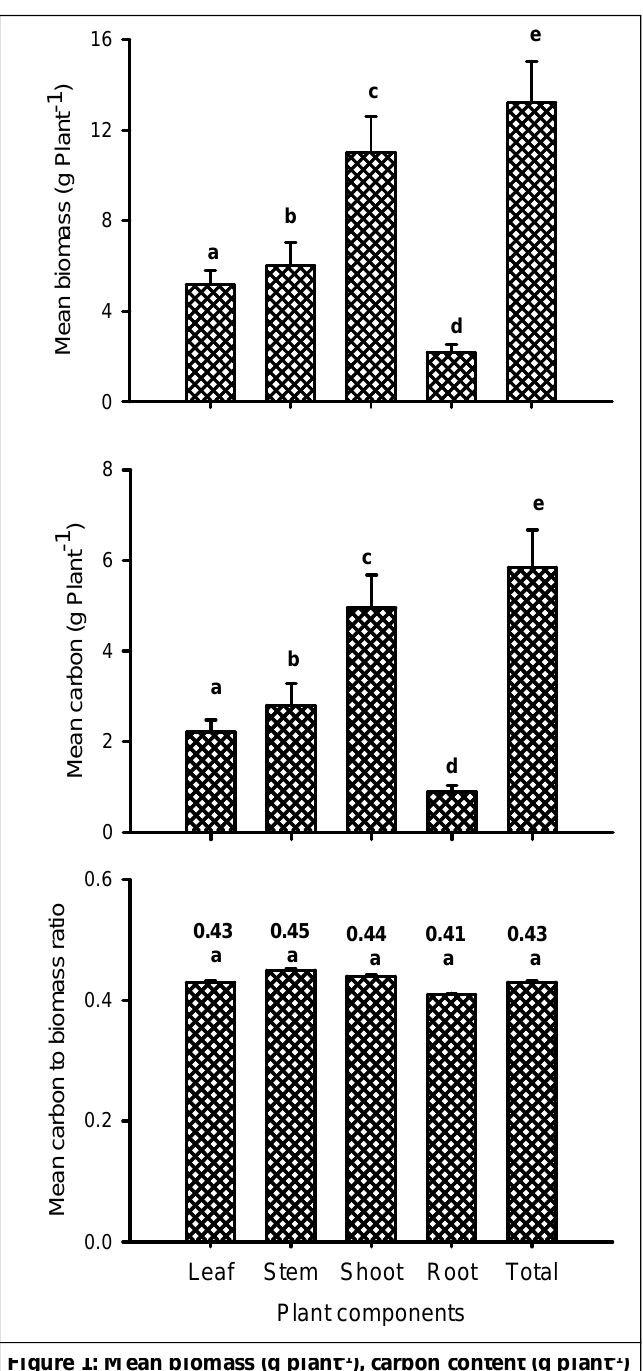
Figure 1: Mean biomass (g plant -1 ), carbon content (g plant -1 ) and carbon to biomass ratio based on 117 herbaceous species for different plant components in the tropical grassland at Varanasi, India. Bars affixed with different letters within each component are significantly different from each